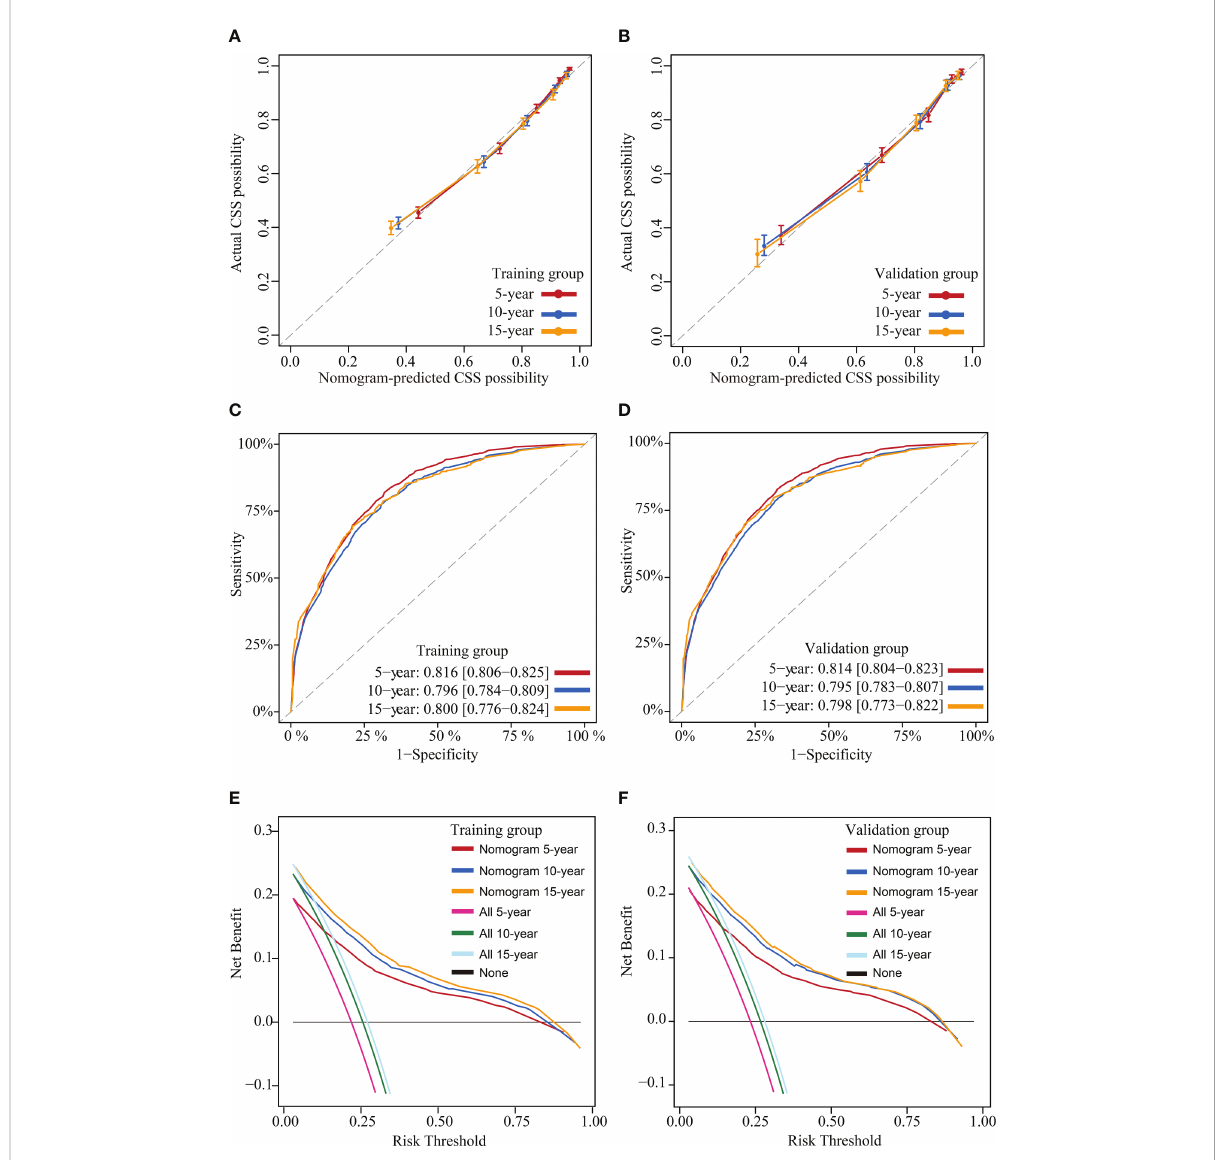
FIGURE 5 Model evaluation and validation. Calibration plots (A) and (B) , Time-dependent receiver operating characteristic (ROC) curves (C) and (D) and decision curve analysis (DCA) curves (E) and (F) for assessing the accuracy, discrimination and clinical usefulness of the conditional survival nomogram (CS-nomogram) at 5-, 10- and 15-years,